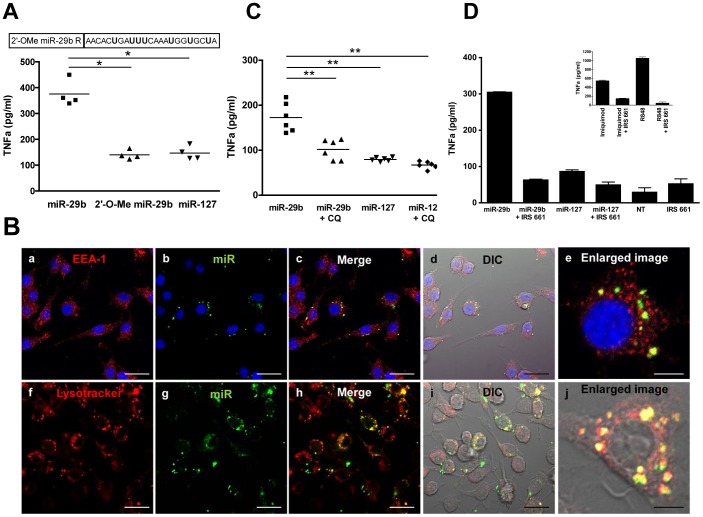
Stimulation of the TLR-7 pathway by miR-29b in murine RAW264.7 macrophages.(A) 2′-O-methyl modifications were introduced in all uracil residues of the miR-29b reverse strand as indicated. RAW264.7 cells were plated four hours before stimulation with DOTAP-embedded miR-29b, 2′-O-Me-modified miR-29b, or the control miR-127 (750 nM working concentration). TNFa was quantified in supernatants eighteen hours later. 2′-O-Me modifications were introduced in the miR-29b reverse strand before annealing to the unmodified guide strand. Results are represented as individual values of cytokine concentrations (pg/ml). Data from one representative experiment out of three is shown. *P<0.05 (Mann-Whitney). (B) Intracellular distribution of Alexa-488-labelled miR-29b 1hour after transfection of RAW264.7 cells was observed with a confocal fluorescence microscope. Top row: IF EEA-1 on fixed cells Bottom row: lysotracker in living cells. Scale bar = 20 µm for fluorescence images and overlays with differential interference contrast (DIC) (a–d, f–i) except for enlarged single cell images scale bar = 5 µm (e, j). (C) Chloroquine (CQ) was added to the plated RAW264.7 cells, at a final concentration of 10 nM, 30 minutes before stimulation with miR-29b or the miR-127 control (750 nM). Supernatants were harvested eighteen hours later for TNFa quantification. Results are represented as individual values of cytokine concentrations (pg/ml) compiled from two independent experiments. **P<0.01 (Mann-Whitney) (D) RAW264.7 cells were stimulated with miR-29b, miR-127 (750 nM), the positive controls TLR-7-ligand imiquimod and R848, or were left untreated (NT), and were cultured eighteen hours with or without the TLR-7 antagonist IRS661. TNFa was quantified in supernatants. Results are presented as mean cytokine concentration of replicates (pg/ml) ± SEM. Data from one representative experiment out of three is shown.